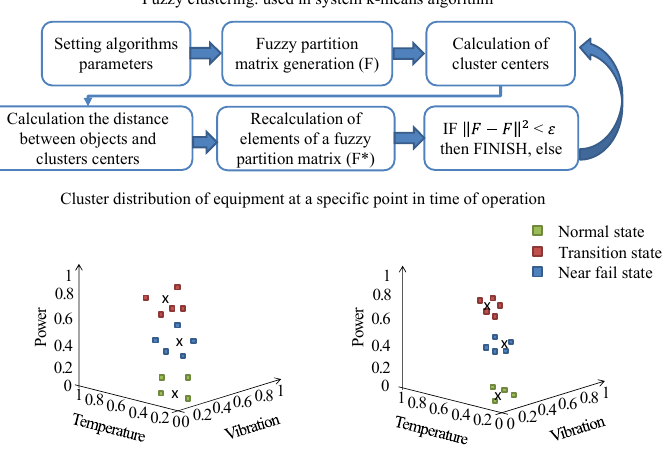
Fig. 1. The operation scheme of the fuzzy clustering